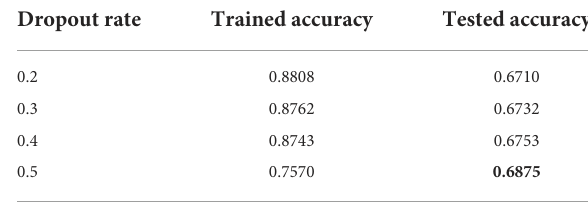
TABLE 9 Comparison of experimental results with different dropout rates.